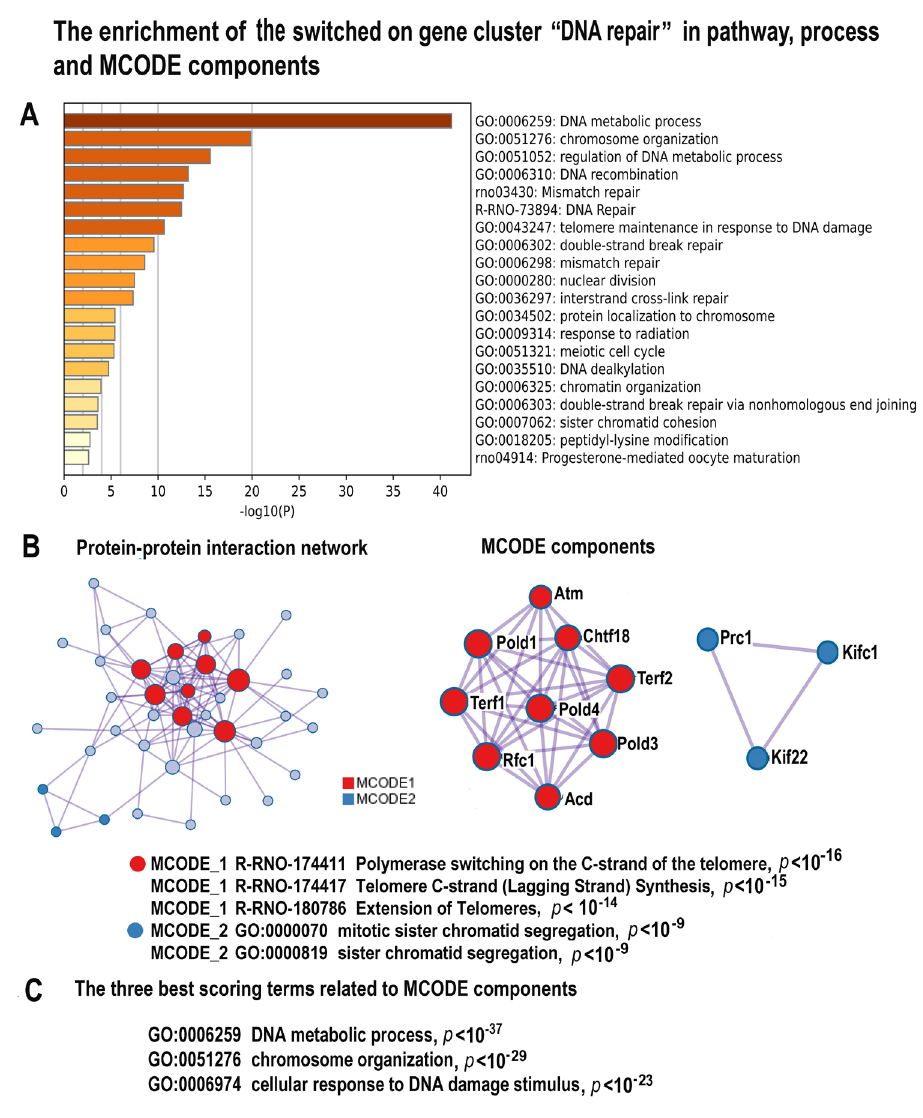
Figure 4. The enrichment of NLI-induced genes related to the cluster “DNA Repair” in gene pathways and in processes and molecular complexes. ( A )—Bar graph of enriched terms related to gene modules and processes across the gene cluster related to DNA repair. The statistical significance of enrichment is shown at the X -axis ( − log10 (( p ))). ( B )—Protein–protein interaction network and MCODE components (or densely connected network components) that were identified in the gene list. The network and MCODE components were constructed on the base of physical interactions taken from String server (physical score > 0.4). The coding by color squares reflects the MCODE components. The coding by color circles indicates the results of MCODE component pathway and process enrichment analysis. ( C )—The three best-scoring terms related to MCODE components.